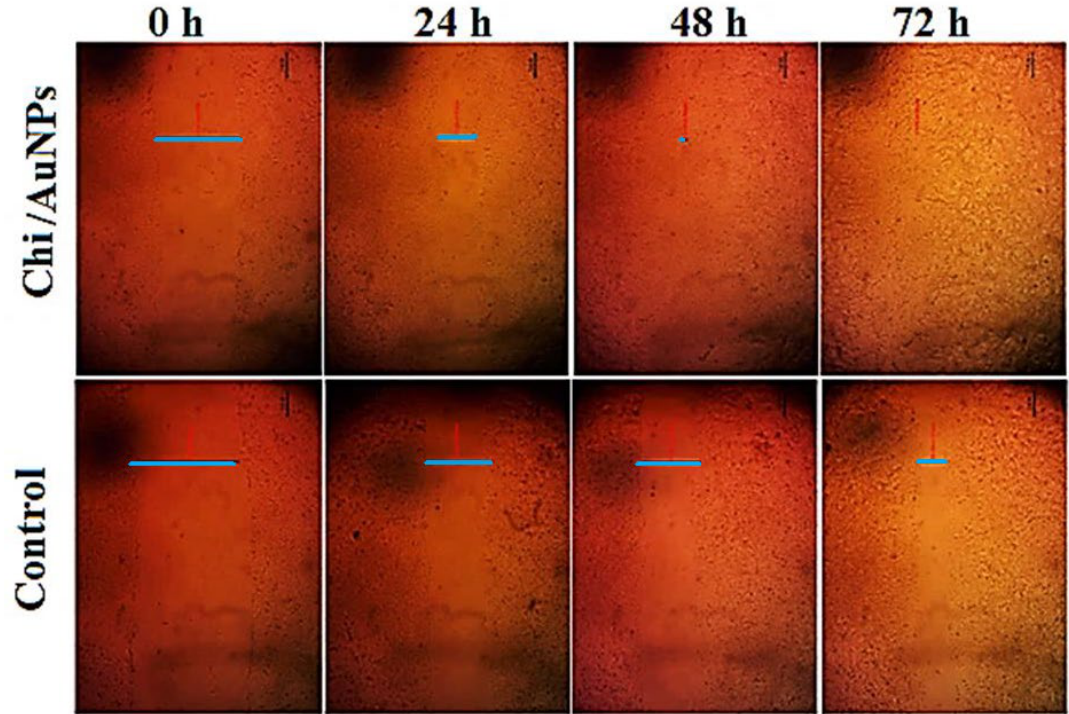
Figure 5. Representative micrograph pictures of cells treated with 100 µg/mL of the tested compound (Chi/AuNPs) and untreated (control) at 0 and 24 h. Wound closure rates are expressed as a percentage of scratch closure after 0 to 96 h compared to the initial area.